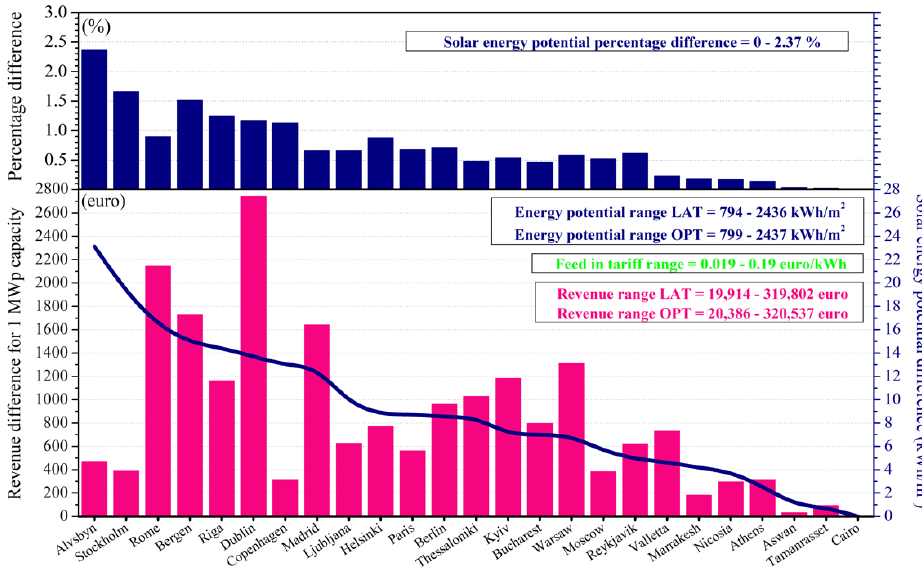
Figure 7. Annual solar energy potential and revenue (for 1 MWp capacity) differences and percentage differences for all cities included in the study, between latitude and optimum tilt angle installations.